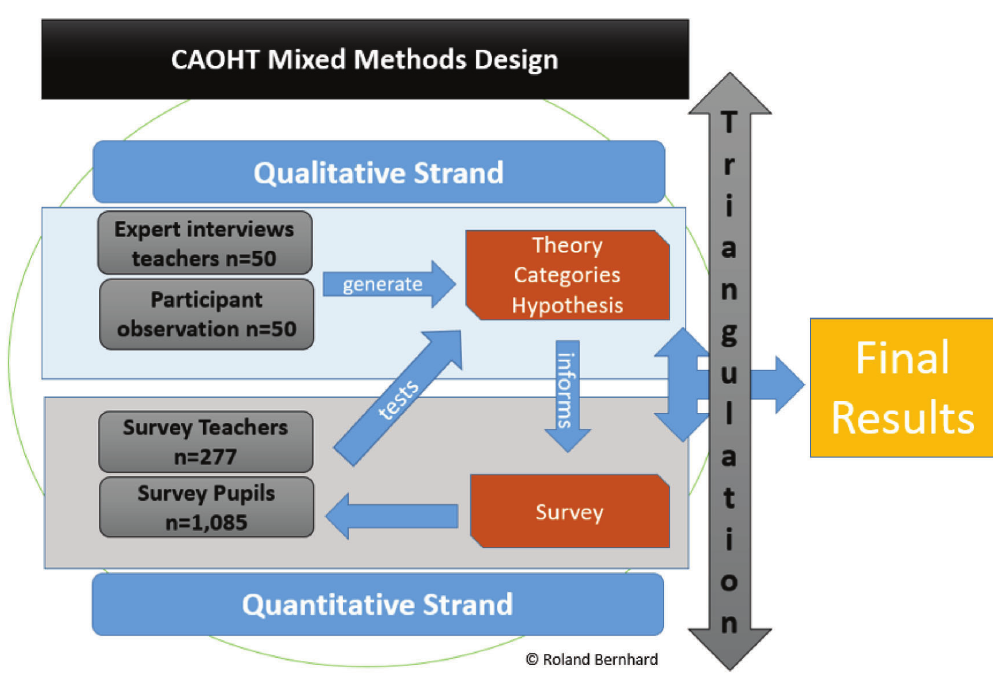
Figure 1: Sequential qualitative–quantitative triangulation (mixed methods) Qualitative data were collected in 26 different schools in Vienna ( Gymnasium and Hauptschulen / Neue Mittelschulen ). Teachers from these schools were recruited on a voluntary basis with the help of school inspectors, principals and colleagues from the University of Education, Vienna. There was a high diversity in the sample of schools and in the sample of teachers. Fifty history lessons were observed and audiotaped (2,430 minutes), and expert interviews with 50 history teachers were conducted (semi-structured, face-to-face; average interview time: 40 minutes) according to the method described in Bogner et al . (2009). The interviews and the observations led to rich textual data that were analysed using MaxQDA. This analysis provided the foundation to construct the quantitative survey (see Bernhard, 2018a). In the next step, the hypotheses generated were tested by a survey study with teachers (n=277) and students (n=1,085) in three different states in Austria (Vienna, Styria and Salzburg). The quantitative data are currently being evaluated to investigate which qualitative findings can be generalized quantitatively for Austria. In other words, the qualitative study helped to identify the core issues and to develop the theoretical concepts and hypotheses that were further examined in the subsequent quantitative study. As Kelle (2006: 307) points out, in such a triangulation design, the subsequent quantitative study is then ‘carried out with the goal of finding out whether concepts relevant in a comparable small number of cases describe and explain social phenomena in a greater domain accordingly’. The overview of the results from both the qualitative and the quantitative strands will provide the final